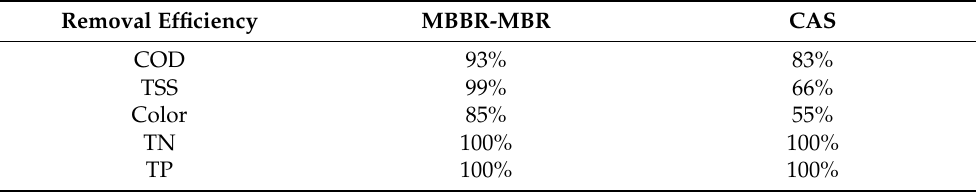
Table 4. Comparison of the treating efficiency of the hybrid MBBR-MBR system and CAS